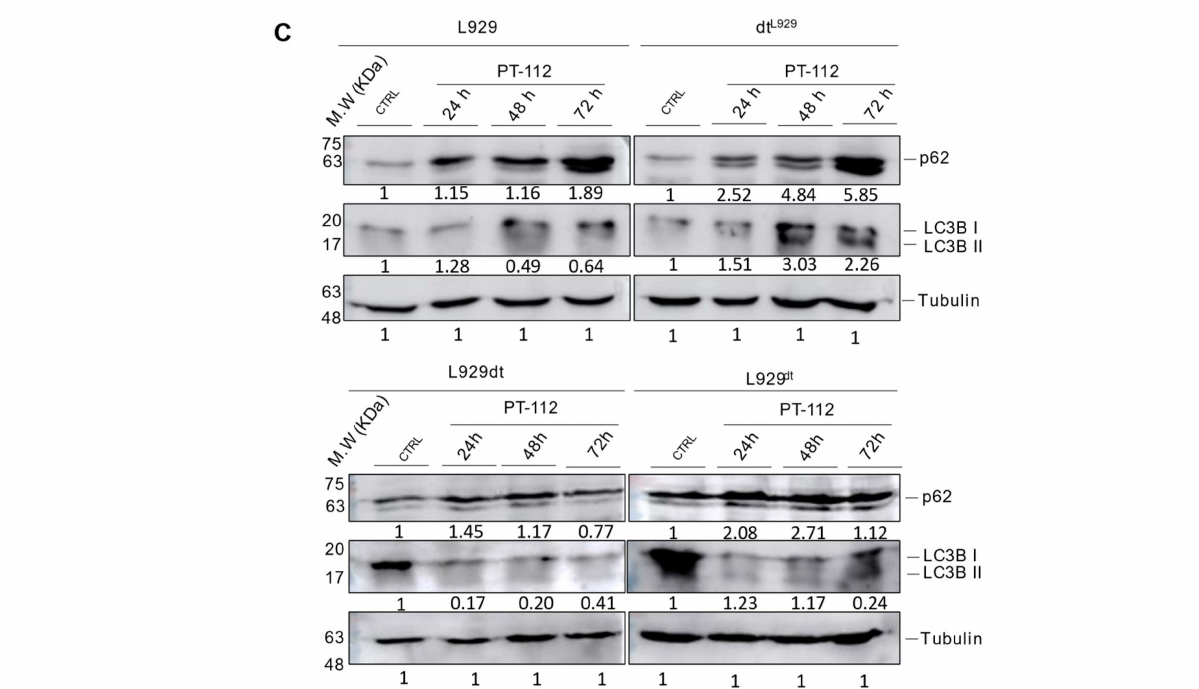
Figure 4. PT-112 induces the initiation of autophagy. ( A ) Analysis of autophagosome formation. Cells were incubated with 10 µ M of PT-112 for 48–72 h. The autophagosome formation was analyzed by flow cytometry using the Cyto-ID ® method. ( B ) Graphical representation of data obtained with Cyto-ID ® analysis. Mean fluorescence intensity (MFI) of treated cells compared to untreated cells is shown. ( C ) Expression levels of p62 and LC3BI/II upon PT-112 treatment. Tubulin was used as a control of protein load. The uncropped blots are shown in Figure